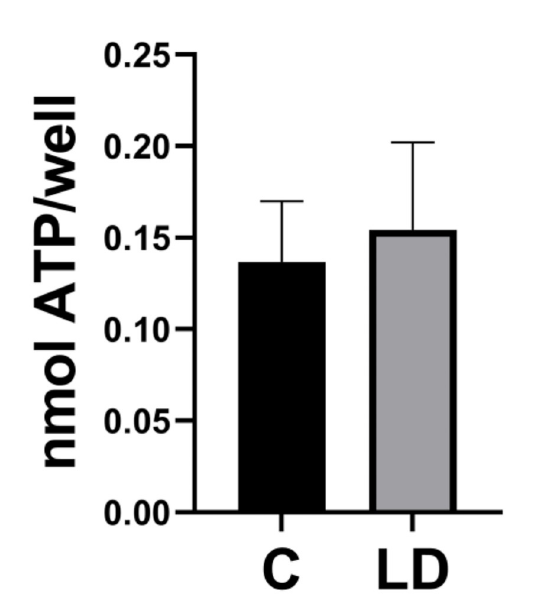
Fig 3. LD-Aag2 cells have equivalent ATP concentration. An ATP assay was performed on C-Aag2 and LD-Aag2 cell lysates in triplicate three days post-feeding with their respective cell culture media. An unpaired Student’s t test was performed between groups to assess statistical significance. Standard deviations are